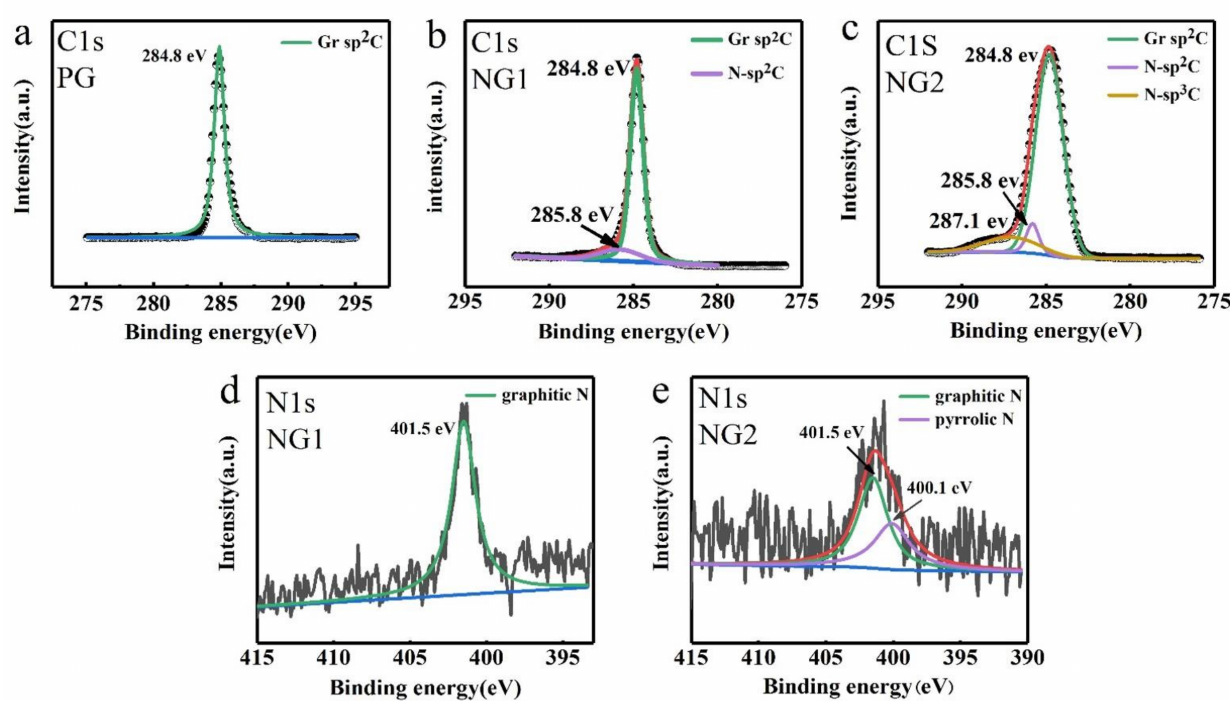
Figure 3. ( a ) XPS core-level C 1s spectra of fresh-prepared PG, ( b ) NG1, and ( c ) NG2; ( d ) XPS core-level N1s spectra of fresh-prepared NG1 and ( e )